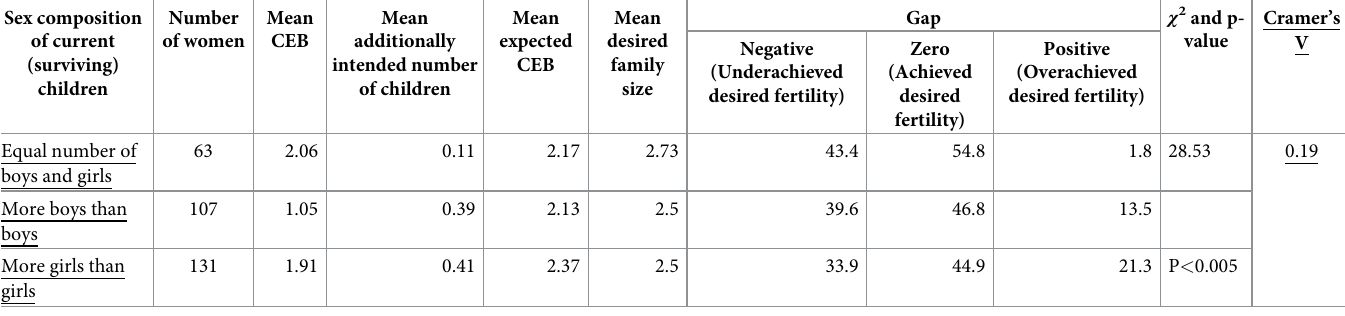
Table 3. Mean number of children ever born (CEB), mean expected CEB, mean desired family size and the gap between mean CEB and mean expected CEB by sex composition of surviving children. Sex composition of current (surviving) children